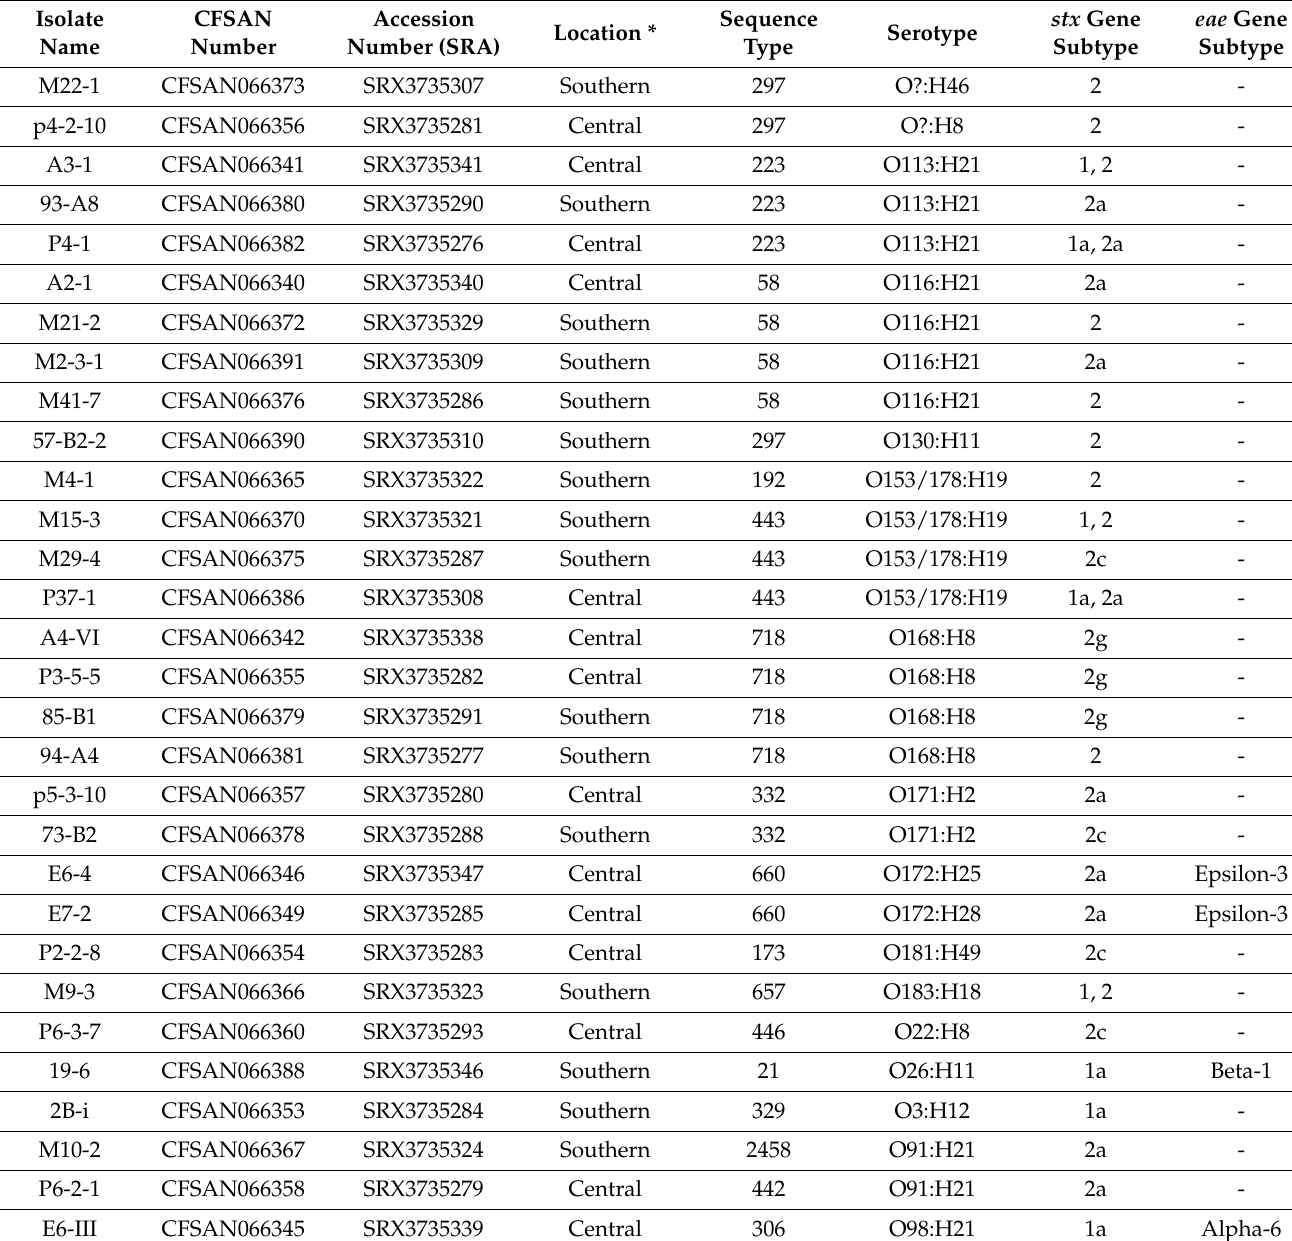
Table 2. Genetic characteristics of sequenced STEC (30) isolated in